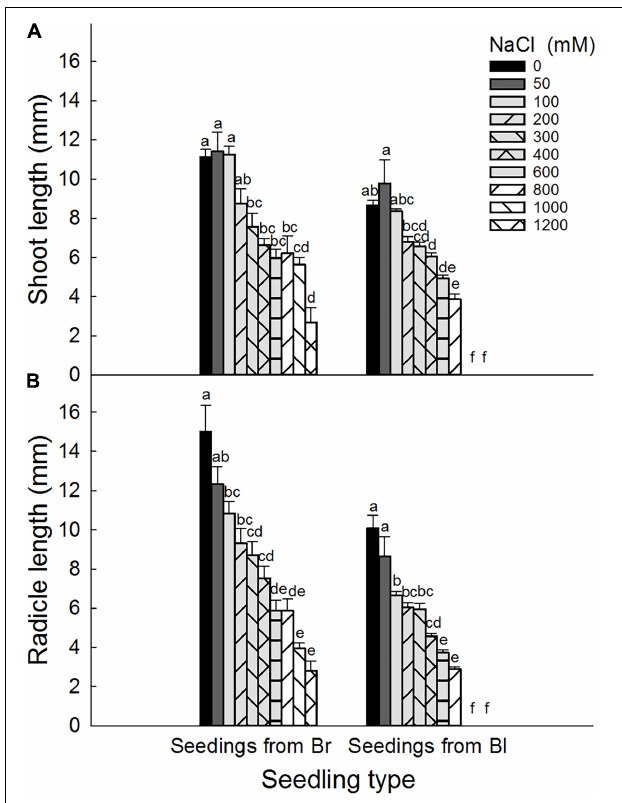
FIGURE 5 | Effect of Na 2 SO 4 on (A) shoot and (B) radicle length of seedlings grown from dimorphic seeds of S. salsa . Br, brown seeds; Bl, black seeds. For each treatment there were 10 biological replicates. Different lower-case letters indicate significant differences in shoot or radicle lengths of seedlings grown from each seed